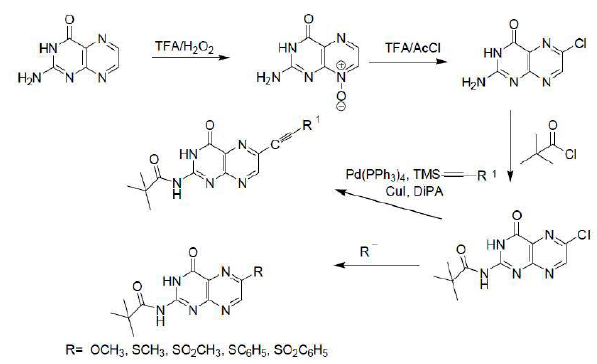
Figure 12: Katada rearrangement.